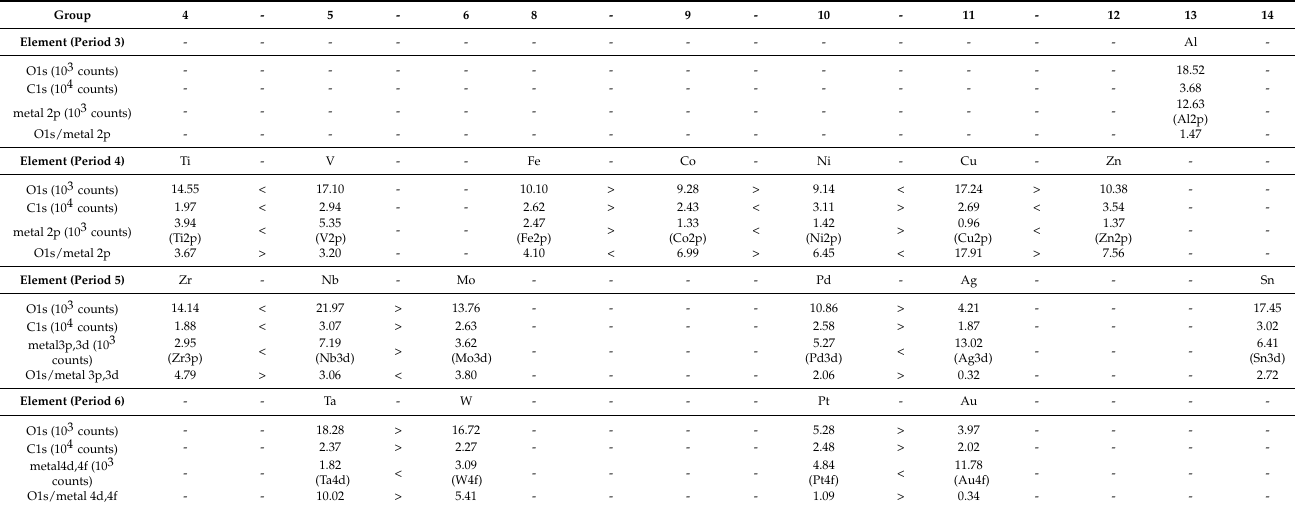
Table 5. The XPS intensities 1 of O1s, C1s, and metal core spectra and the intensity ratio of O1s/metal core before TriboEE measurement of used metals, which were ultrasonically cleaned in a mixture of acetone and petroleum. Group